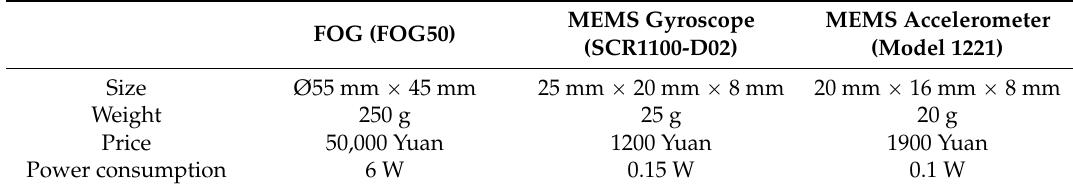
Table 1. Comparison of the three types of sensors.